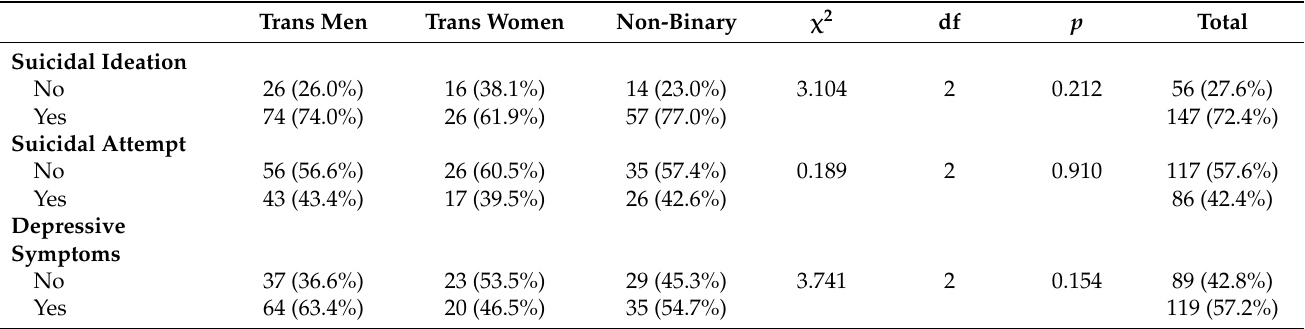
Table 2. Mental health variables by gender.